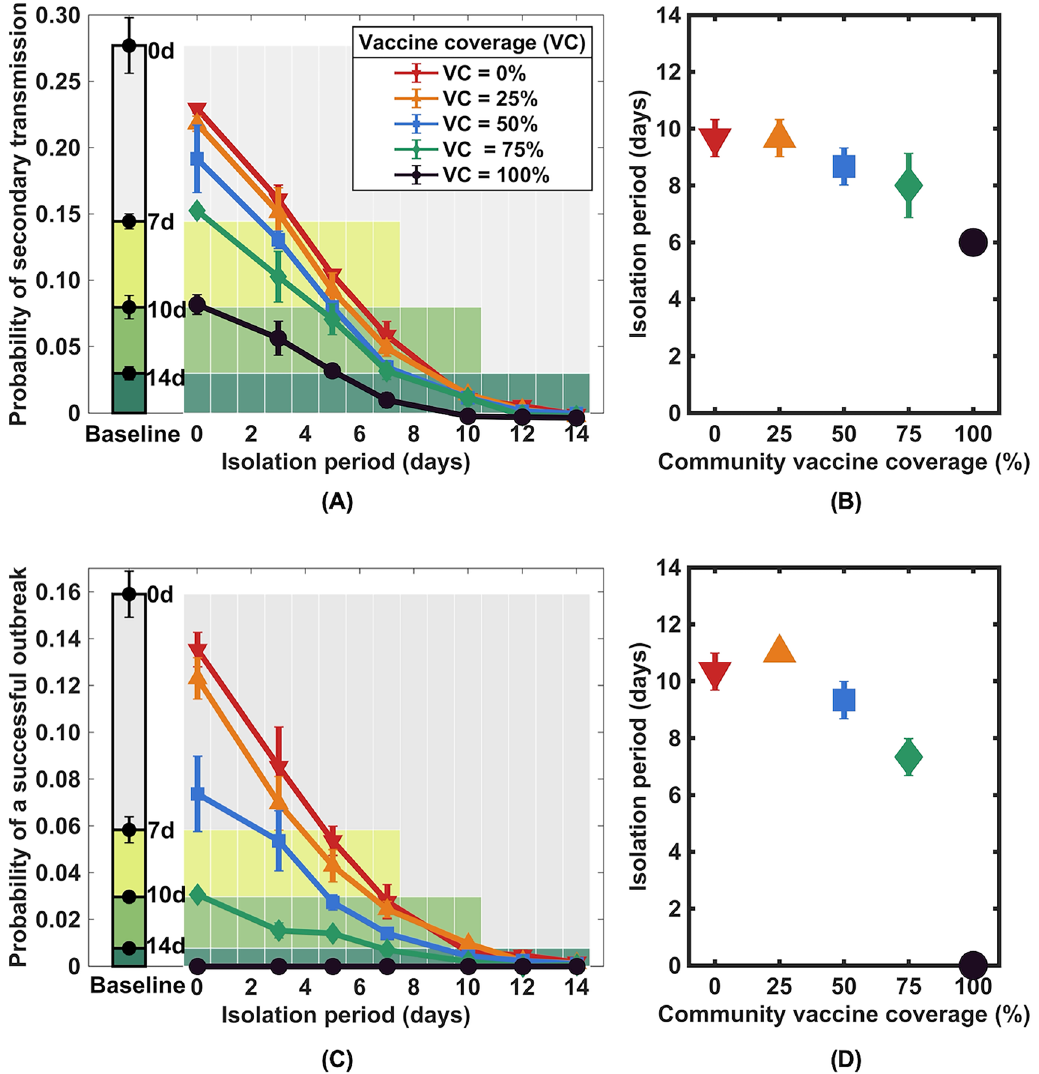
Figure 3. Impact of isolating a primary vaccinated infected individual on post-isolation transmission. Probability of secondary transmission ( A ) and probability of a successful outbreak in which a chain of transmission can be sustained ( C ) after a range of isolation periods and vaccination levels in the community. The corresponding probabilities in the baseline scenario where the primary case and all other individuals in the community are unvaccinated are shown as bar graphs on the left side of both subfigures. ( B ) and ( D ) show the isolation period equivalent to the 14-day isolation period in the baseline scenarios regarding the probability of secondary transmission and the probability of a successful outbreak, respectively. Error bars indicate 95%